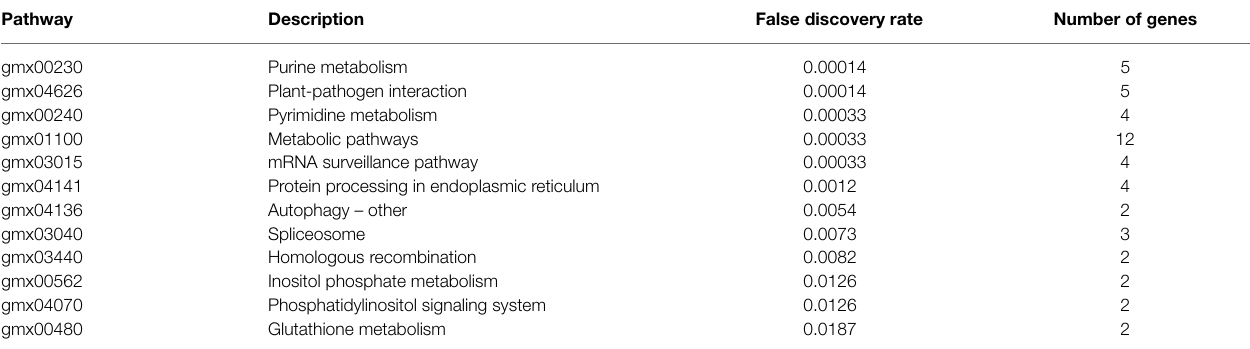
TABLE 5 | KEGG_Pathway of soybean to resist Phytophthora infection sRNA targeting soybean mRNA.